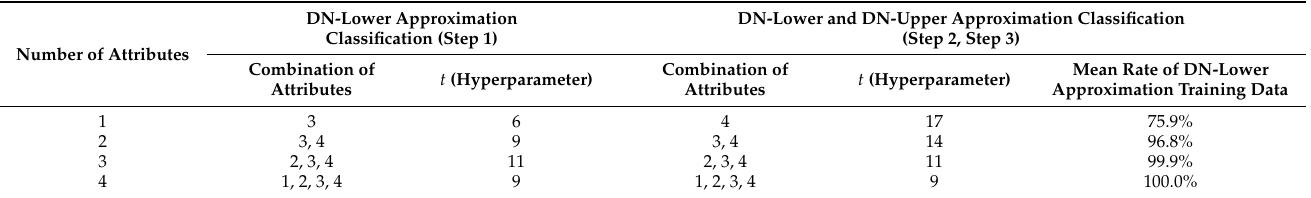
Table 5. Optimal hyperparameters of the DNRS model for Iris.